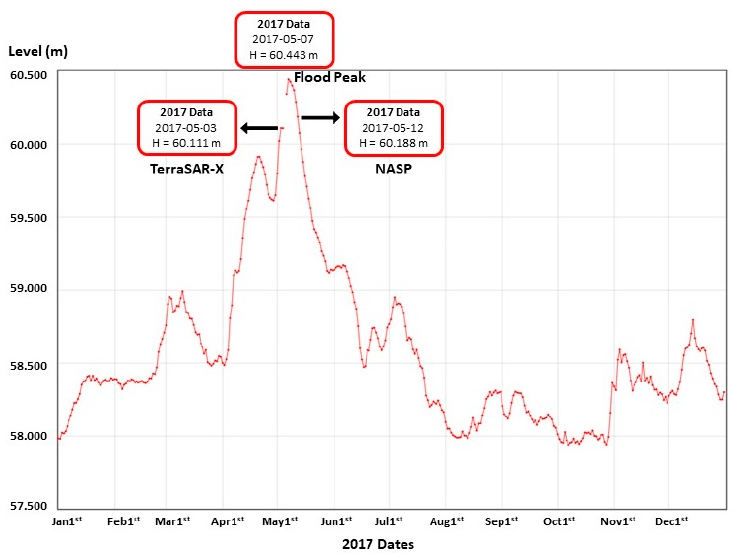
Figure 2. Water level comparison on 3 May 2017, 7 May 2017, and 12 May 2017; data extracted from the Water Survey of Canada Hydrometric Station 02KF005.